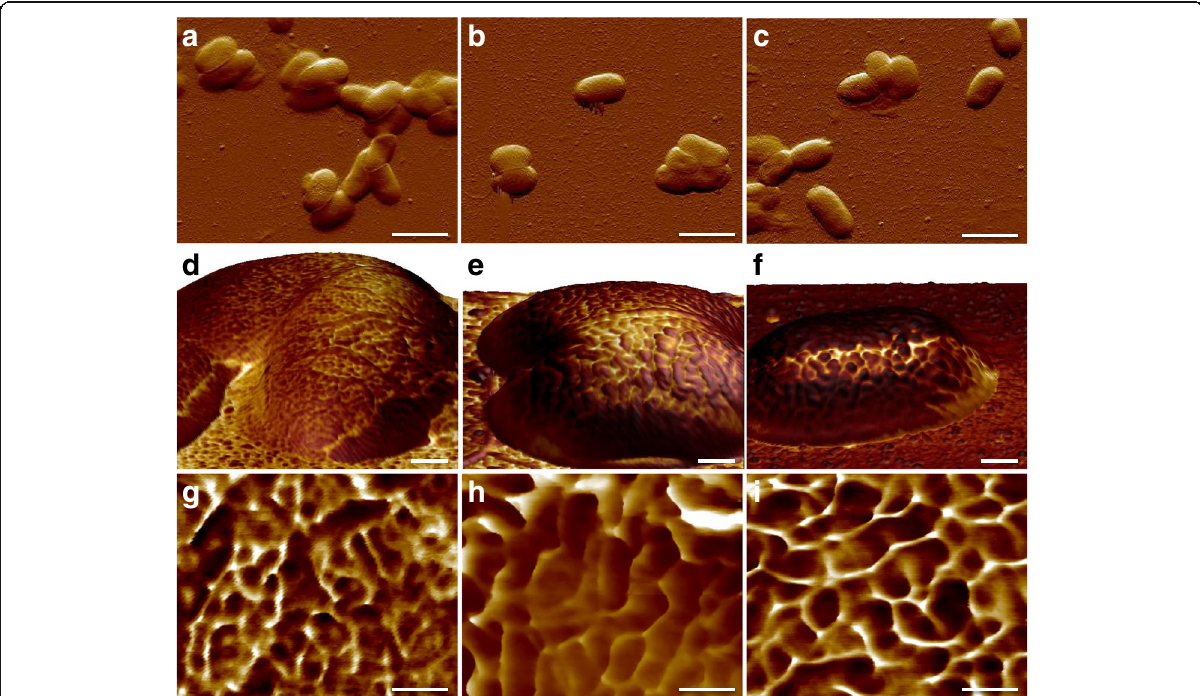
Fig. 3 Morphological characteristics of the E. coli genotypes. The upper row displayed the deflection error images of a MG1655, b CFT073, and c RS218. The middle row showed the 3D topographies colored with adhesion mapping on d MG1655, e CFT073, and f RS218 cells. The lower row was the detailed adhesion mapping on g MG1655, h CFT073, and i RS218. In adhesion mapping, the darker color referred to less adhesion performances and vice versa. The scale bars were 2 μ m for a – c , 200 nm for d – f , and 100 nm for g – i